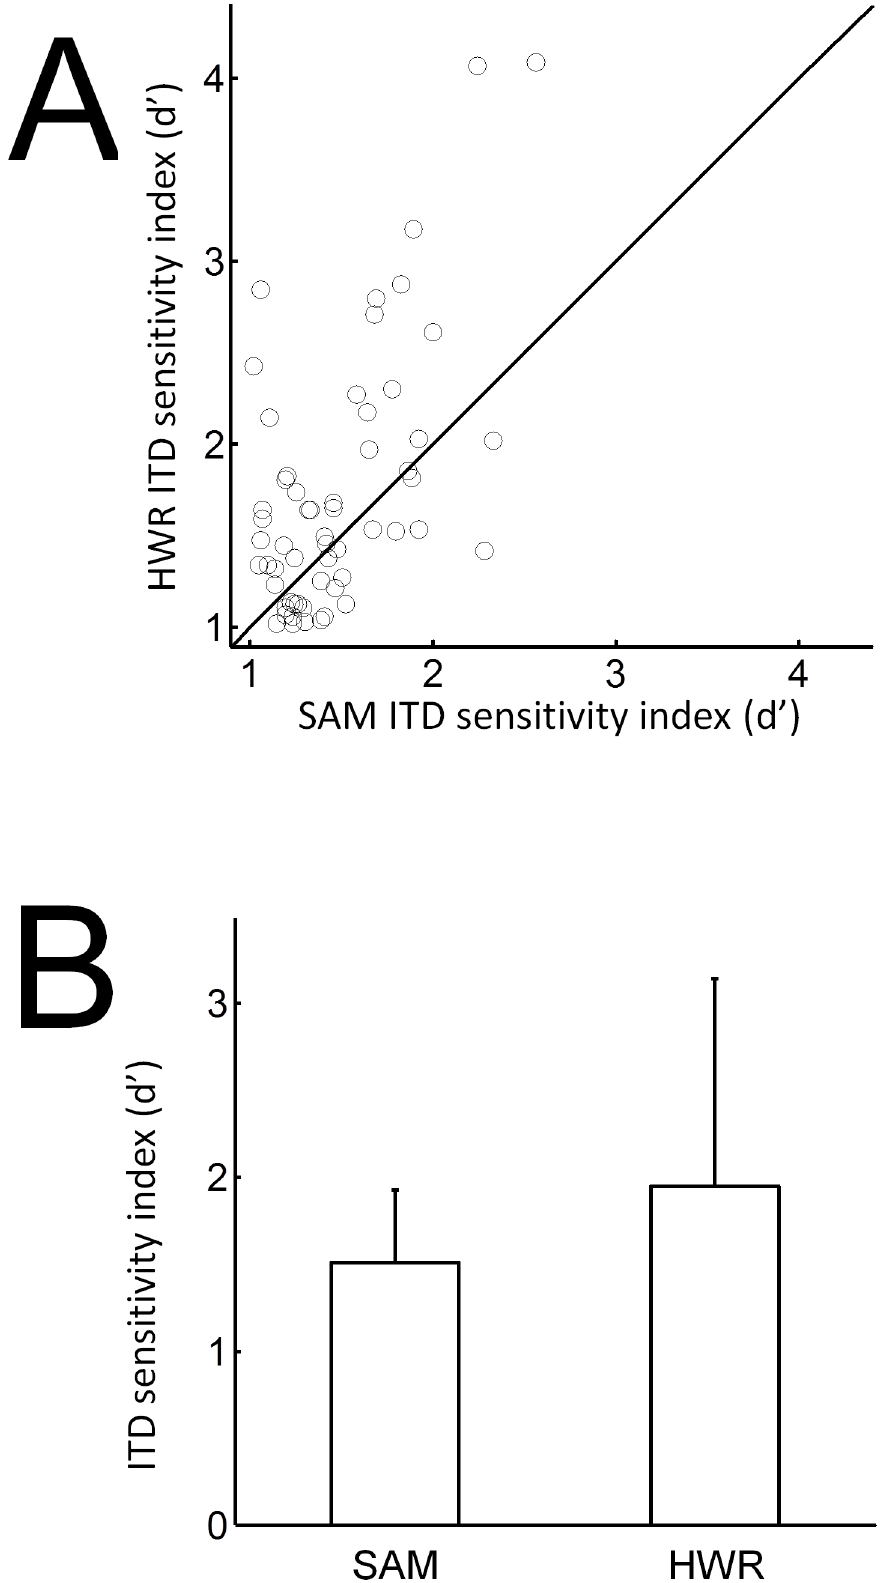
Figure 14. ITD sensitivity index in deaf animals with cochlear implants. (A) ITD sensitivity index for individual units plotted for offset responses to SAM and HWR pulse trains. (B) Mean ITD sensitivity index ( 6 SD) plotted against stimulus condition for offset responses.